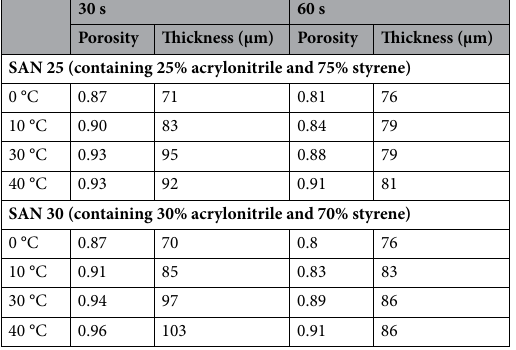
Table 1. The porosity and thickness of SAN 25 and SAN 35 at different water bath temperatures and BWB times using DMF as a solvent, polymer concentration = 8%; Casting knife gap = 250